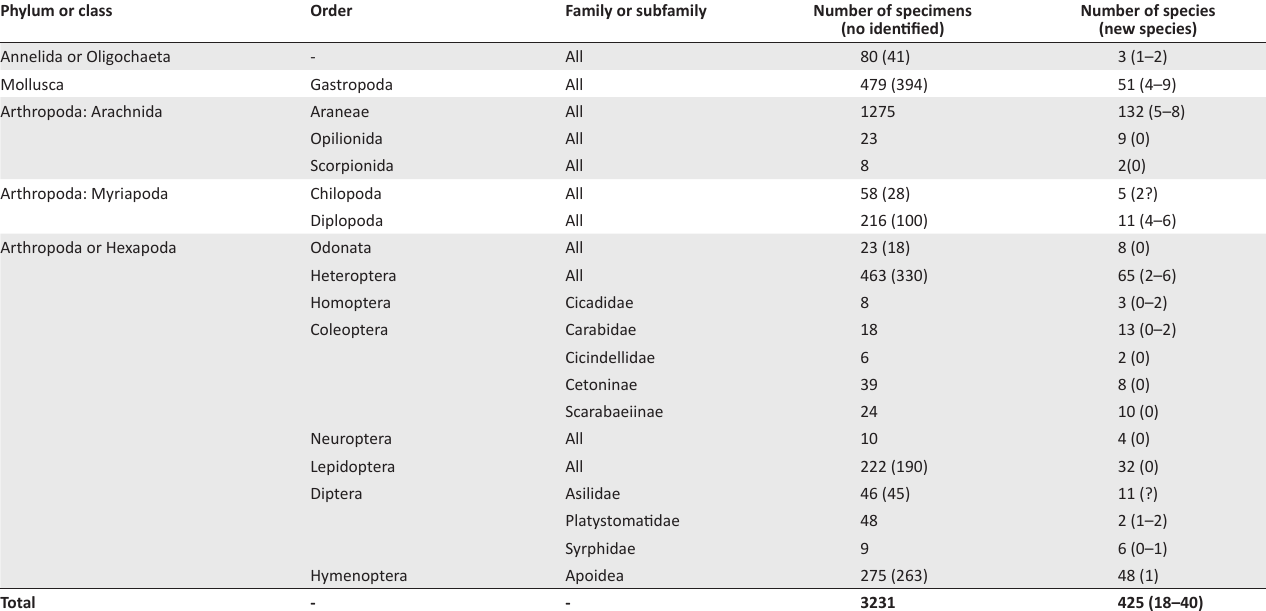
TABLE 1: Summary of number of specimens collected, identified, number of species and number of new species collected for each of the target taxa at Mkambati Nature Reserve. Phylum or